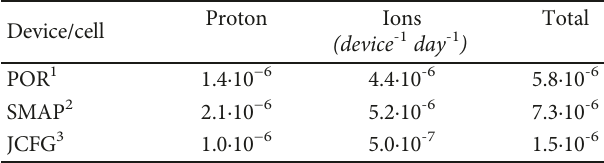
Table 6: SEFI rates for Virtex-II for OPTOS radiation